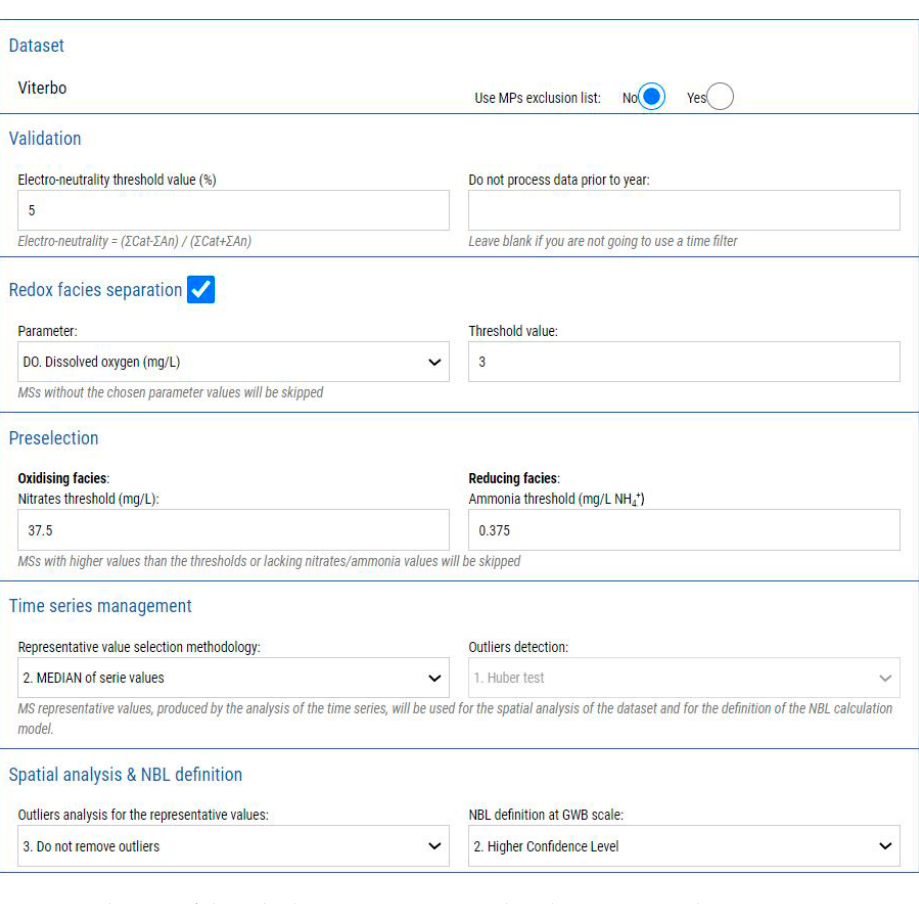
Figure 3. Selection of the calculation parameters within the eNaBLe tool.